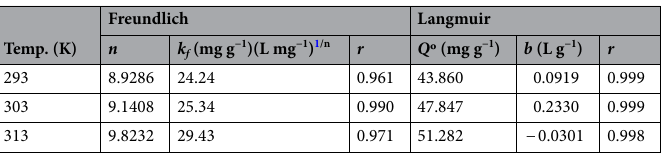
Table 2. Freundlich and Langmuir isotherm parameters for Pd(II) adsorption by 1 -EIR.